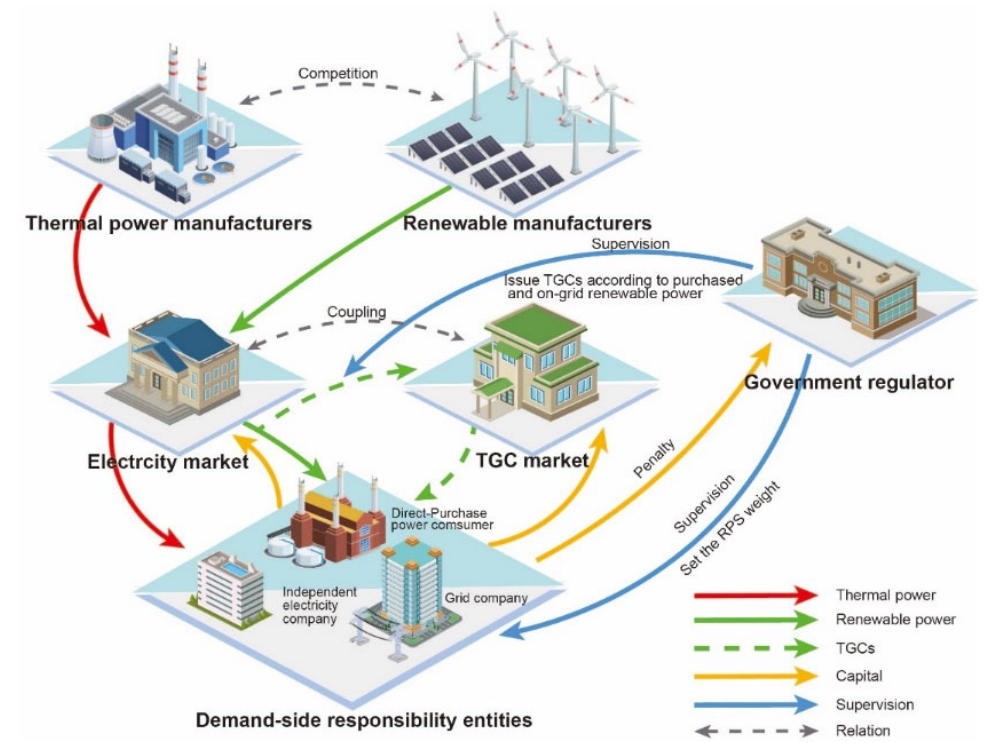
Figure 2. Interaction between the TGC market and the electricity market.